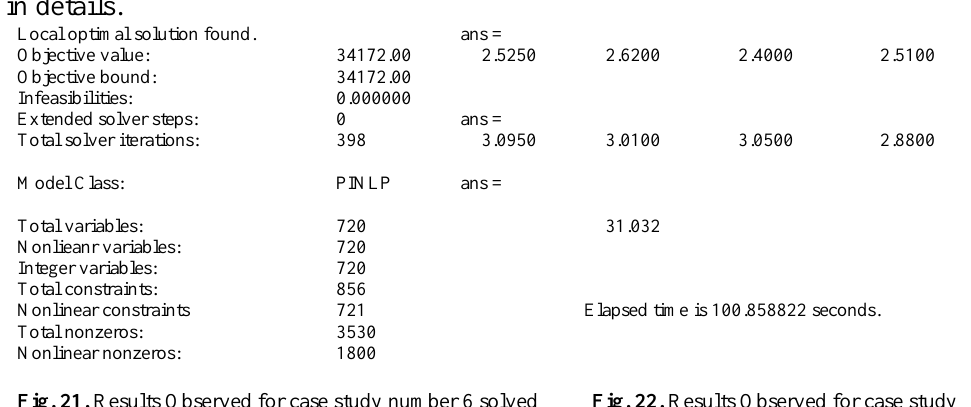
Fig. 21. Results Observed for case study number 6 solved with Lingo 12.0 (medium size problem)